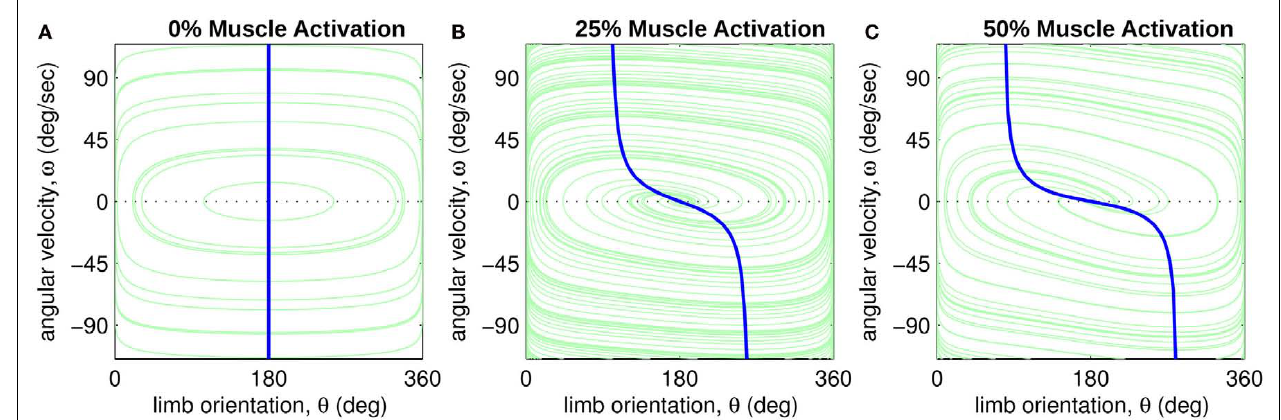
FIGURE 3 | Phase portraits of the motion of an isolated limb segment actuated by an opposing pair of symmetric muscles under conditions of (A) nil co-activation ( a a = a b = 0), (B) 25% co-activation ( a a = a b = 0.25) and (C) 50% co-activation ( a a = a b = 0.5). The latter approximates the biological limit of muscle co-contraction in nature. All other musculoskeletal parameters are identical in all three conditions ( m = 5, L = 1, φ = 0.2, F max = 1, k l =− π 2 /ln(0.1), k v = 2, k pe = 0.1, ˆ θ 0 = π , ˆ θ = 0, ˆ θ = 2 π ). Horizontal axis in each panel represents the angular min max position of the limb segment ( θ ) and is synonymous with both joint angle